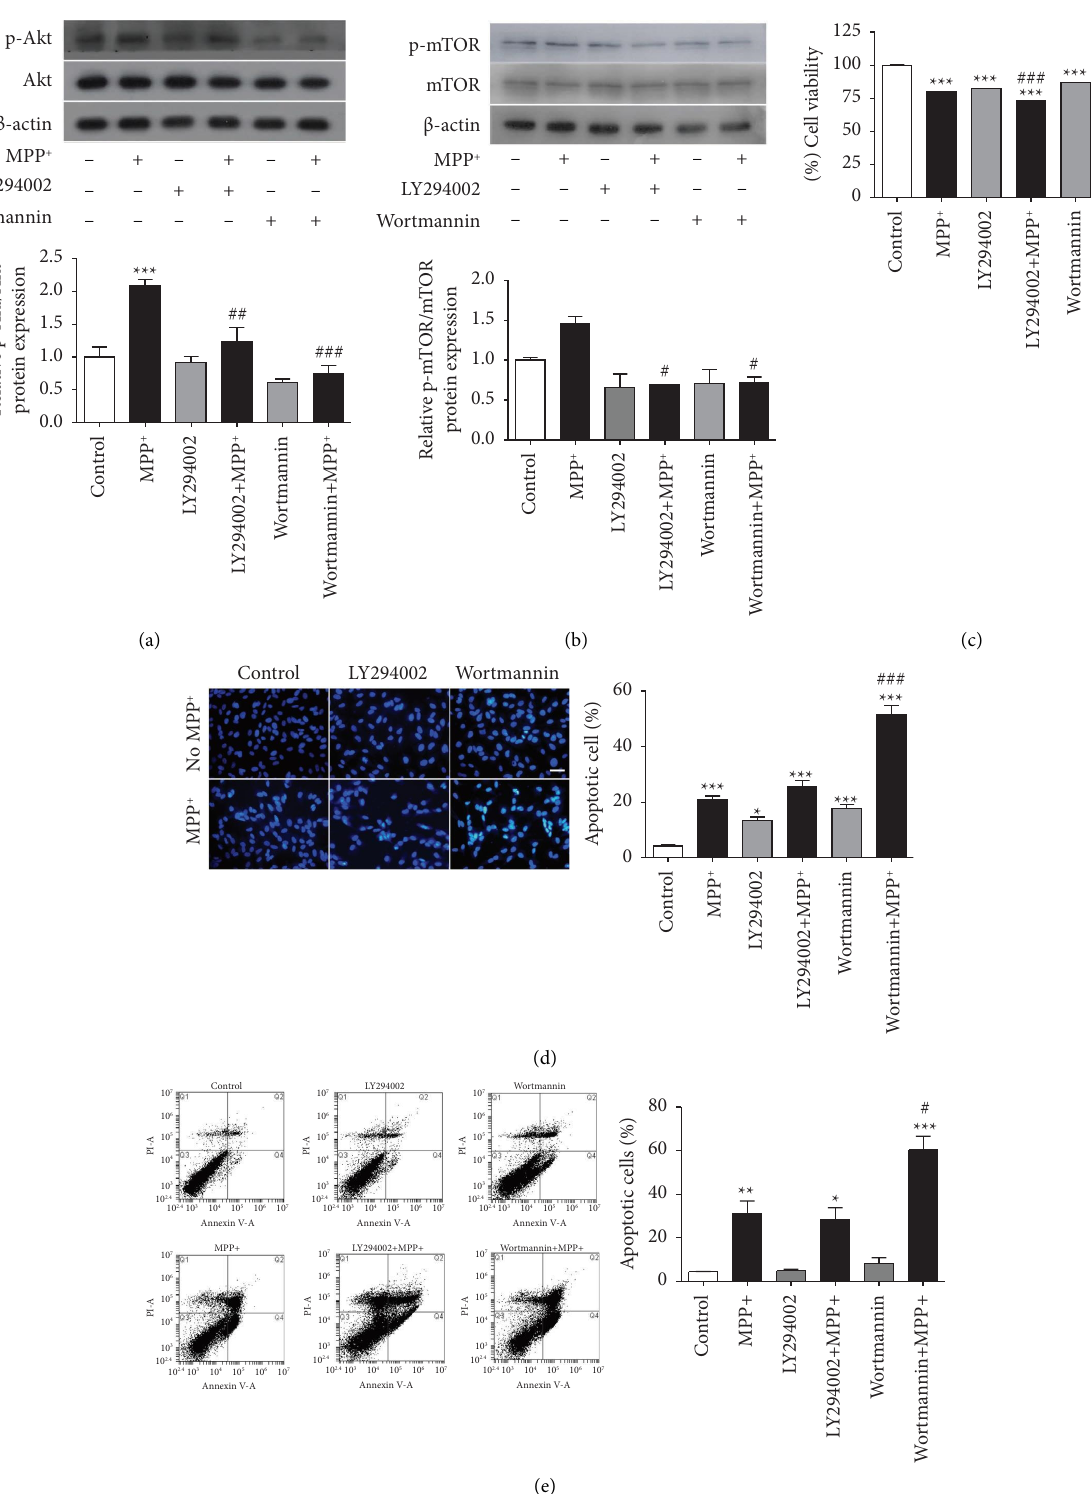
Figure 4: PI3K inhibitors reduce phospho-Akt and phospho-mTOR and potentiate cell death in MPP + -treated SH-SY5Y neuronal cells. (a) Immunoblots of phospho-Akt protein. (b) Immunoblots of phospho-mTOR protein. Te density of the bands was normalized with that of β -actin protein. (c) Cell viability examined using the MTTassay. (d) Apoptotic nuclear morphology observed using Hoechst 33258 staining. Scale bar � 30 µ m. Graph represents the percentage of cells with apoptotic nuclei. (e) Graphs represent the percentage of Annexin V-positive cells obtained from Annexin V/PI fow cytometry. Data are expressed as mean ± SEM ( n � 3). ∗ p < 0 . 05, ∗∗ p < 0 . 01, ∗∗∗ p < 0 . 001 versus control; # p < 0 . 05, ## p < 0 . 01, ### p < 0 . 001 versus MPP +